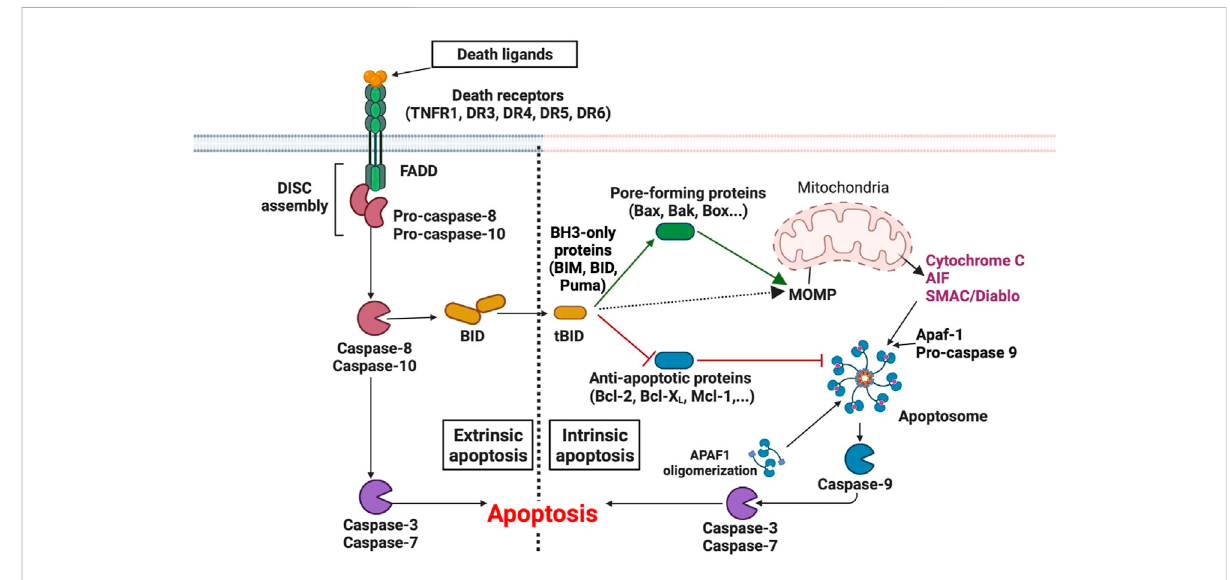
FIGURE 1 Molecular mechanisms of